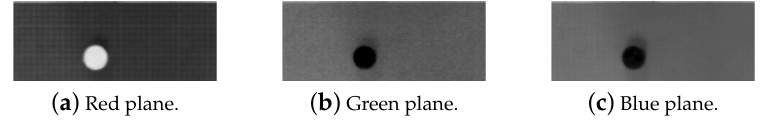
Figure 12. Grayscale of the RGB planes corresponding to the circle in Figure 11.